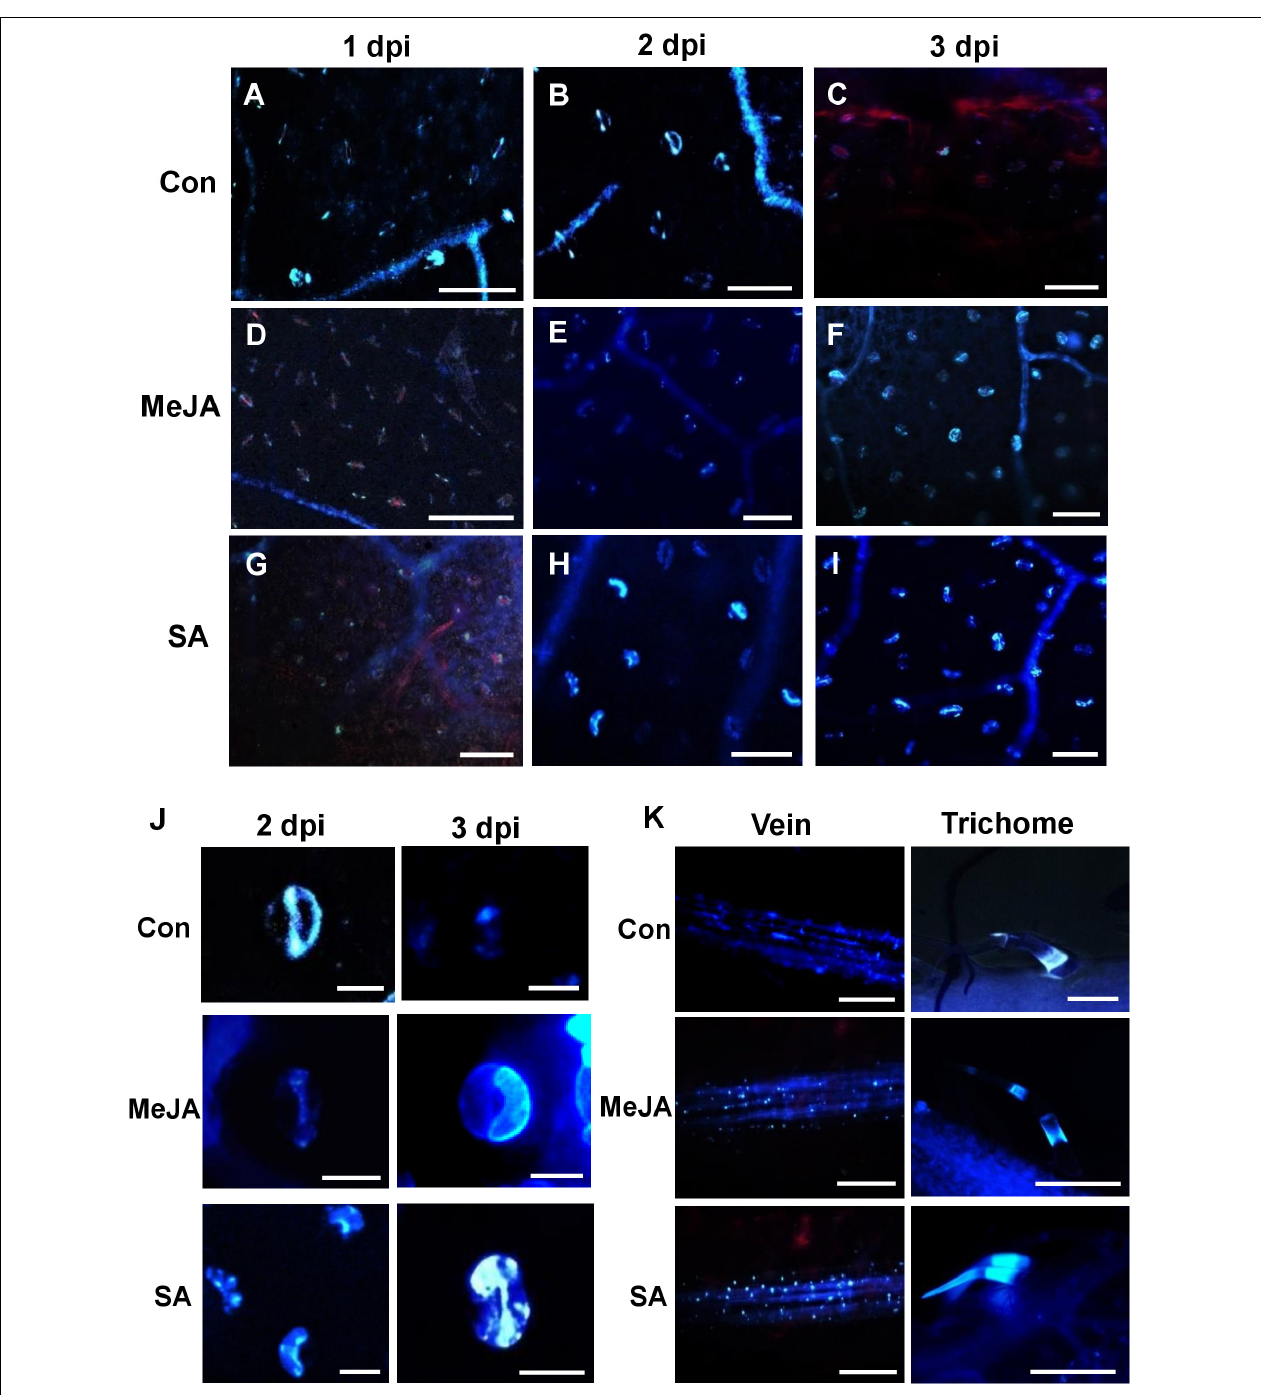
FIGURE 10 | Comparison of callose deposition on the leaf surface, veins, stomata, and trichomes show that SA priming enhanced callose deposition in response to infection in the early phases while MeJA enhanced in the later phases. (A–C) The control plants show early callose deposition on leaf surface, veins, and stomata over the first two days of infection, while on the third day callose is degraded due to necrosis. (D–F) Deposition of callose in the veins, stomatal guard cells in MeJA-primed leaves with more prominent deposition starting on the 3 dpi (G–I) Callose deposition in the SA-primed leaves started on the second day and was significantly more than that of MeJA-primed plants. Three images were analyzed from four individual replicates. Bar = 50 µ m. (J) Enlarged view of the stomata at 2 and 3 dpi. In the control leaves, only one of the guard cells of each stoma fluoresced on 2 dpi and then by third day it diminishes. In MeJA, no fluorescence on 1–2 dpi but both guard cells fluorescence on 3 dpi. In SA-primed leaves, at 1 dpi there is no fluorescence, at 2 dpi only one guard cell fluorescence and in the following day both of the guard cells fluoresce. (K) Anniline blue fluorescence of the veins and trichomes at 2 dpi shows less callose deposition in the control compared to the phytohormone primes leaves. Bar = 300 µ